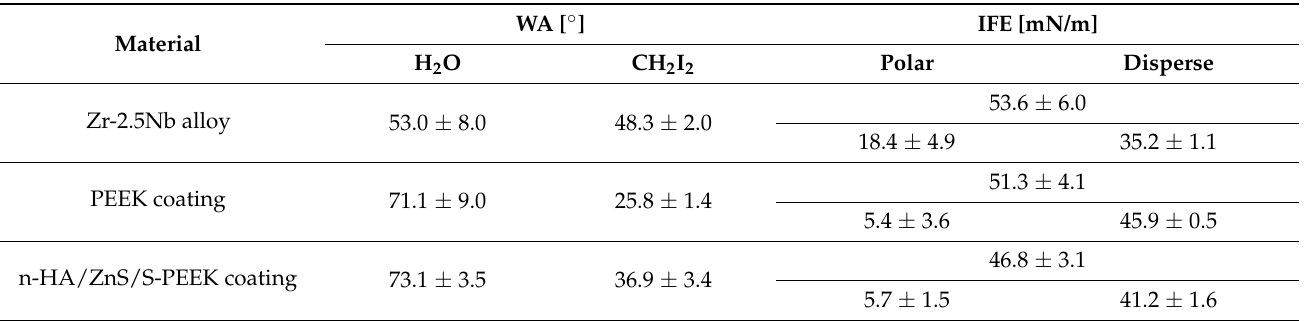
Figure 12. 3D image of the n-HA/ZnS/PEEK coating surface after heat treatment at 450 ◦ C, optical profilometry. Table 1. Water and diiodomethane wettability angle and interfacial free energy of the Zr-2.5Nb alloy, PEEK and n-HA/ZnS/S-PEEK